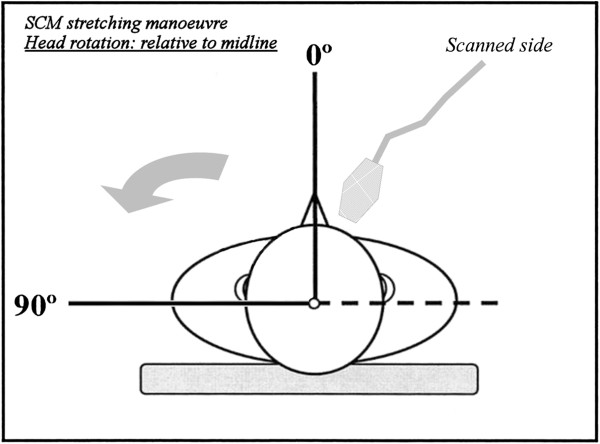
Maximum contralateral head rotation compared to the scanned side.